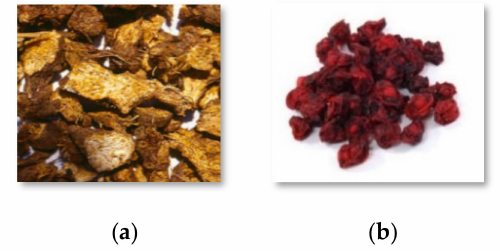
Figure 1. Natural substances of CKD-497: ( a ) Atractylodis Rhizoma Alba; ( b ) Schisandra chinensis